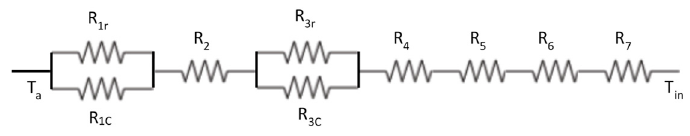
Figure 2. Thermal resistances of the gable roof.